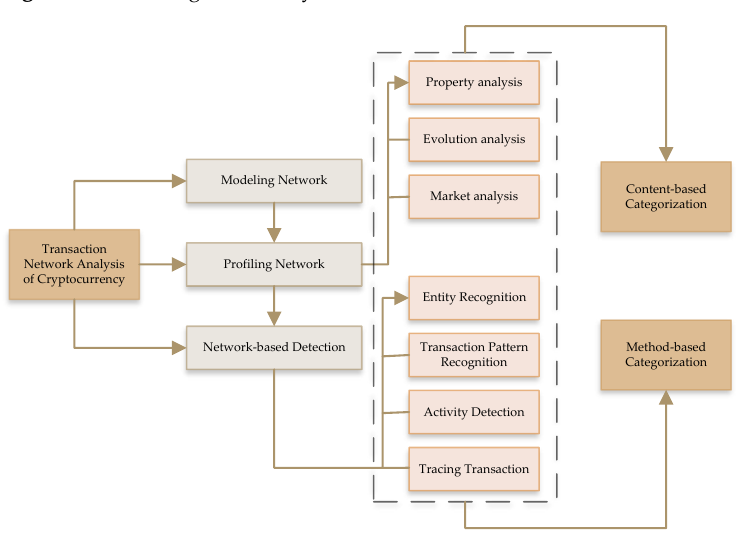
Figure 4. Knowledge discovery based on a blockchain framework.